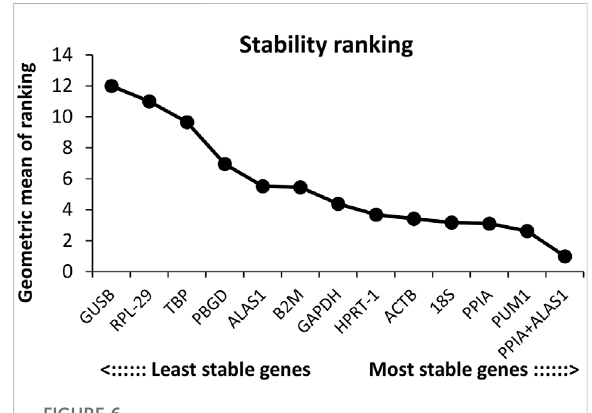
FIGURE 6 Overall ranking of the candidate reference genes ’